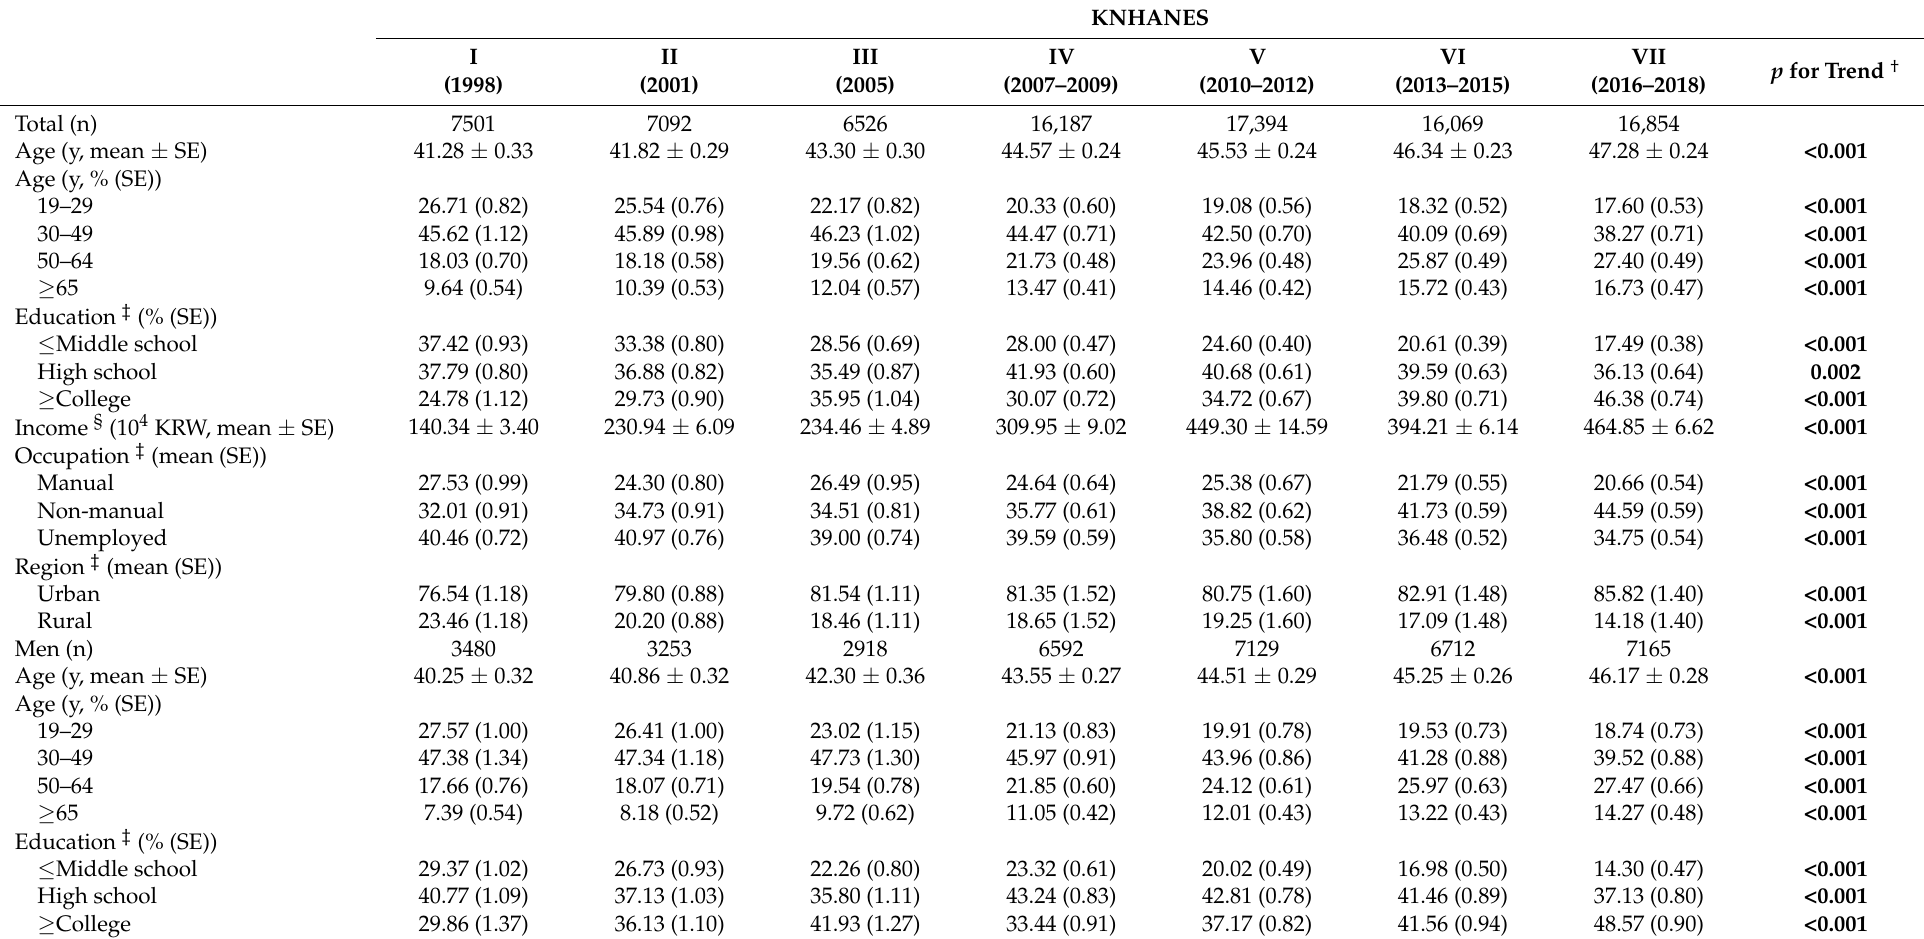
Table 1. Trends in general characteristics of Korean adults ≥ 19 years from 1998 to 2018 using the Korea National Health and Nutrition Examination Survey (KNHANES).